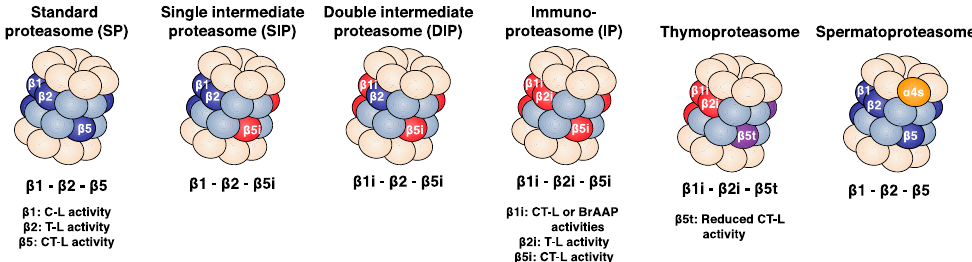
Figure 2. There are six proteasome subtypes that differ in their subunit composition. The standard proteasome (SP) contains the constitutive catalytic subunits β 1, β 2 and β 5, while the immunoproteasome (IP) contains the immuno-subunits β 1i, β 2i and β 5i. The intermediate proteasomes comprise a mixed assortment of constitutive and inducible subunits: the single intermediate proteasome (SIP) contains β 1, β 2 and β 5i, while the double intermediate proteasome (DIP) contains β 1i, β 2 and β 5i. The thymoproteasome contains catalytic subunit β 5t, which is homologous to β 5 and β 5i, along with subunits β 1i and β 2i. Each catalytic subunit is characterized by different cleavage specificities as indicated in the lower part of the figure. Finally, the spermatoproteasome contains an α 4s subunit instead of the standard α 4 and expresses, in its catalytic chamber, the same assortment of catalytic subunits as the SP. Abbreviations used: caspase-like (C-L), trypsin-like (T-L), chymotrypsin-like (CT-L), and branched amino-acid preferring activity (BrAAP).